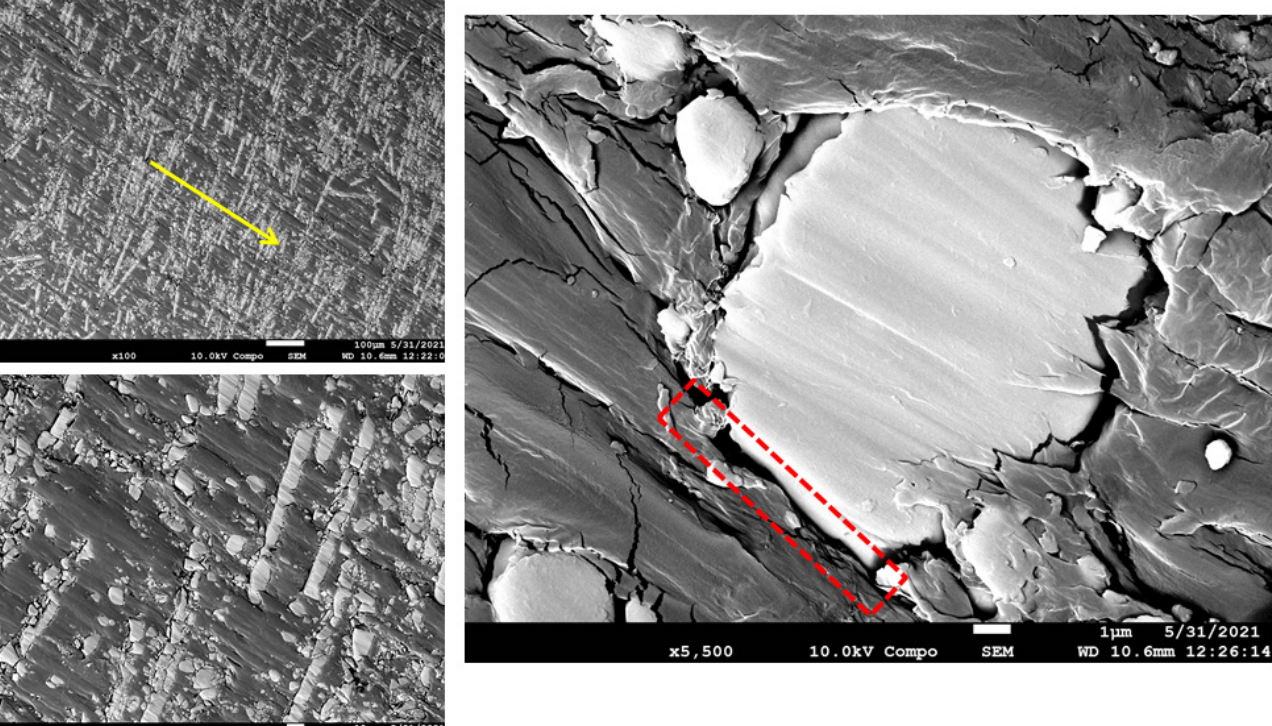
Figure 16. FESEM Micrographs for the worn-out surfaces of PA633GF at different magnifications.